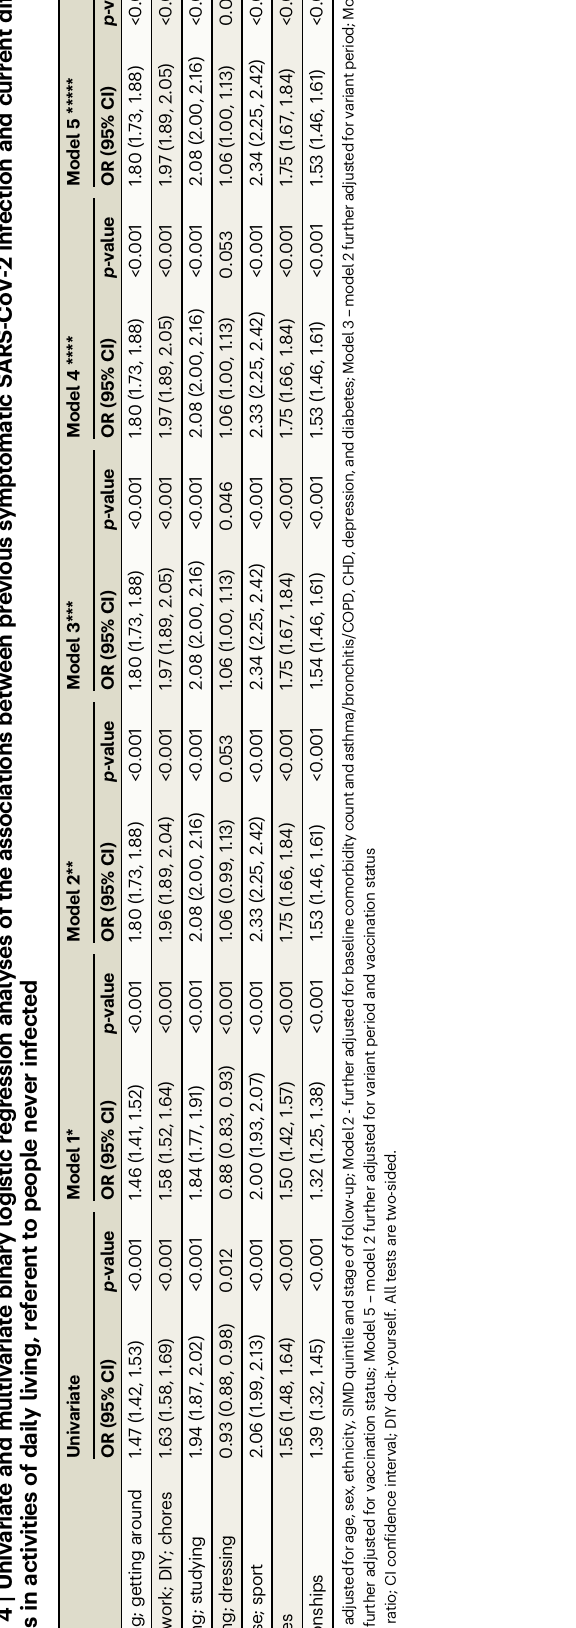
No recov- Partial recovery ery ( n =1,856) ( n =13,350)